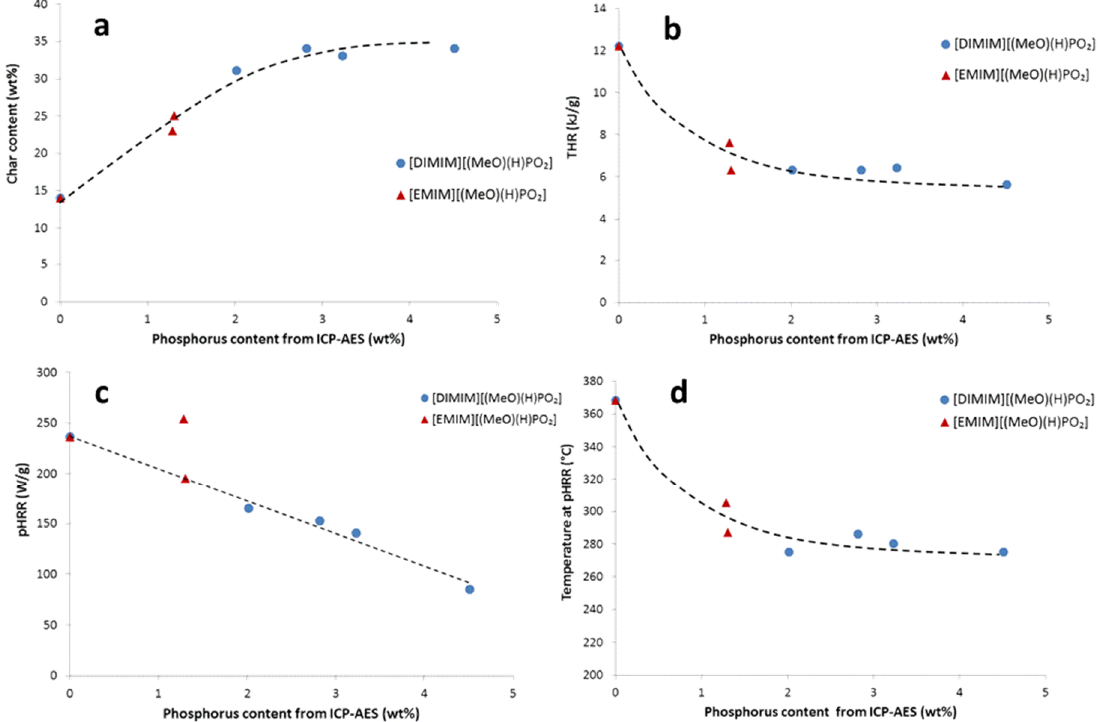
Figure 8. The influence of phosphorus content in the modified cellulose on ( a ) char content, ( b ) THR, ( c ) pHRR, and ( d ) temperature at pHRR from PCFC analysis.